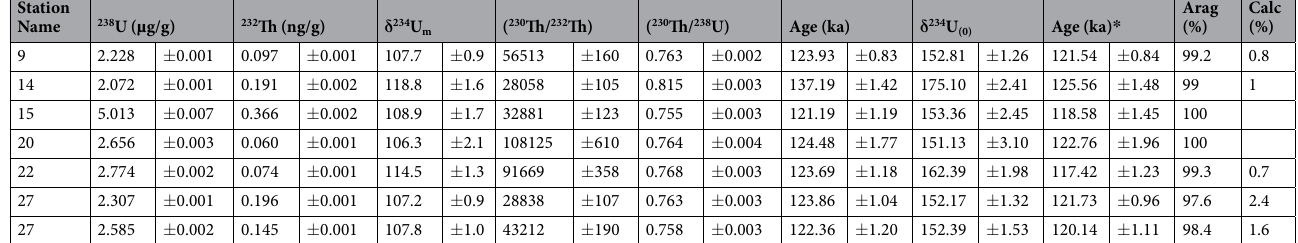
Table 2. Uranium-series and XRD measurements for samples collected within the strata of MIS5e terraces along the Saudi Arabian coast of the Gulf of Aqaba. Location coordinates are given in Table 1. 238 U and 232 Th concentrations were determined using the enriched 236 U and 229 Th isotopes, respectively. and ( 234 U/ 238 U) eq is the atomic ratio at secular equilibrium. δ 234 U (0) is the initial value and is calculated by